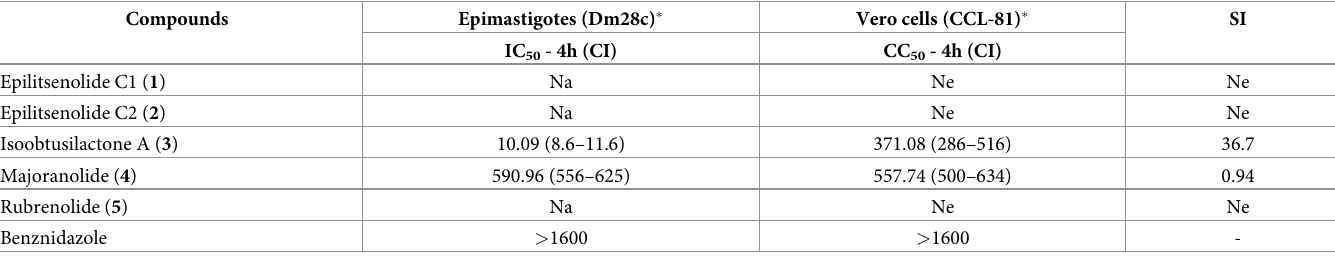
Table 2. Activity after a short period of treatment of butanolides and benznidazole against epimastigotes of T . cruzi . Compounds Epimastigotes (Dm28c) � Vero cells (CCL-81) � SI IC 50 - 4h (CI) CC 50 - 4h (CI) Epilitsenolide C1 ( 1 ) Na Ne Ne Epilitsenolide C2 ( 2 ) Na Ne Ne Isoobtusilactone A ( 3 ) 10.09 (8.6–11.6) 371.08 (286–516) 36.7 Majoranolide ( 4 ) 590.96 (556–625) 557.74 (500–634) 0.94 Rubrenolide ( 5 ) Na Ne Ne Benznidazole > 1600 > 1600 - Inhibition concentration of 50% (IC 50 ); Cytotoxic concentration of 50% (CC 50 ); Selectivity index (SI); Confidence intervals (CI); Not evaluated (Ne); Not active (Na) � Results expressed in micromolar ( μ